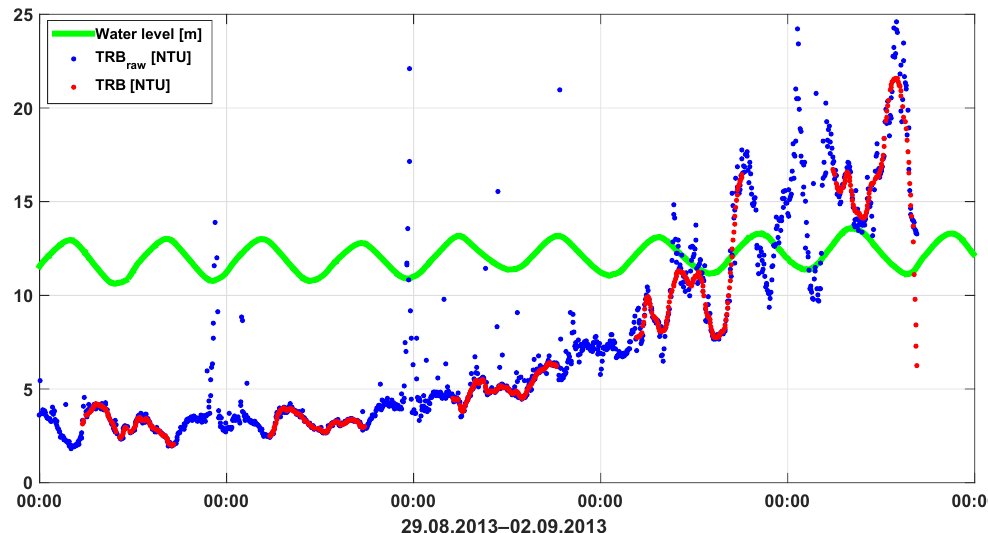
Figure 6. Turbidity data in NTU from 29 August 2013 to 2 September 2013, limited in range (0–25NTU), blue: raw data, red: quality checked data, and green: water level in